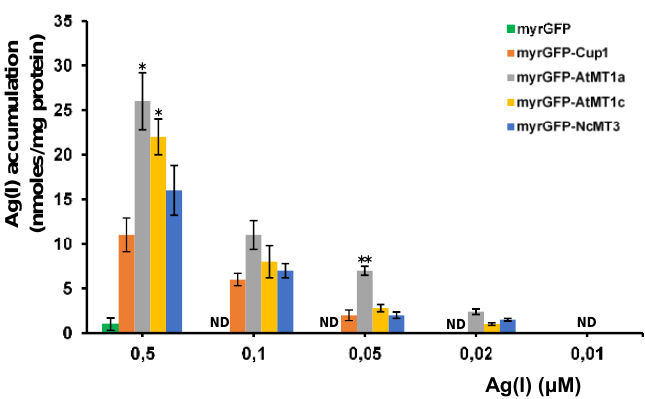
Figure 6. Ag(I) accumulation from media containing trace Ag(I) concentrations. The cup2 ∆ cells transformed with URA3 -based plasmids harboring myrGFP (control), myrGFP-Cup1 (ScMT), myrGFP-AtMT1a, myrGFP-AtMT1c, and myrGFP-NcMT3 under the control of GAL1 promoter were pregrown in MMLC/Raf-Ura then shifted to MMLC/Gal-Ura for transgene induction. After 6 h, cells were shifted to MMLC/Gal-Ura containing low concentrations of Ag(I). Metal accumulation was assayed after 10 h incubation (30 ◦ C, 200 rpm. Two-way ANOVA followed by Bonferroni’s test compared to control myrGFP. * p < 0.05; ** p < 0.01.